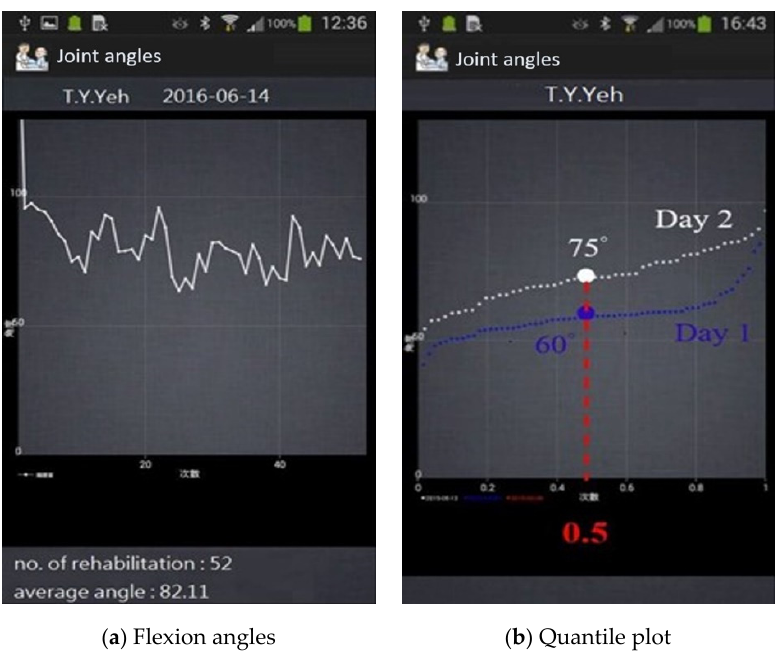
Figure 12. Comparisons of swing progress in quantile plots.